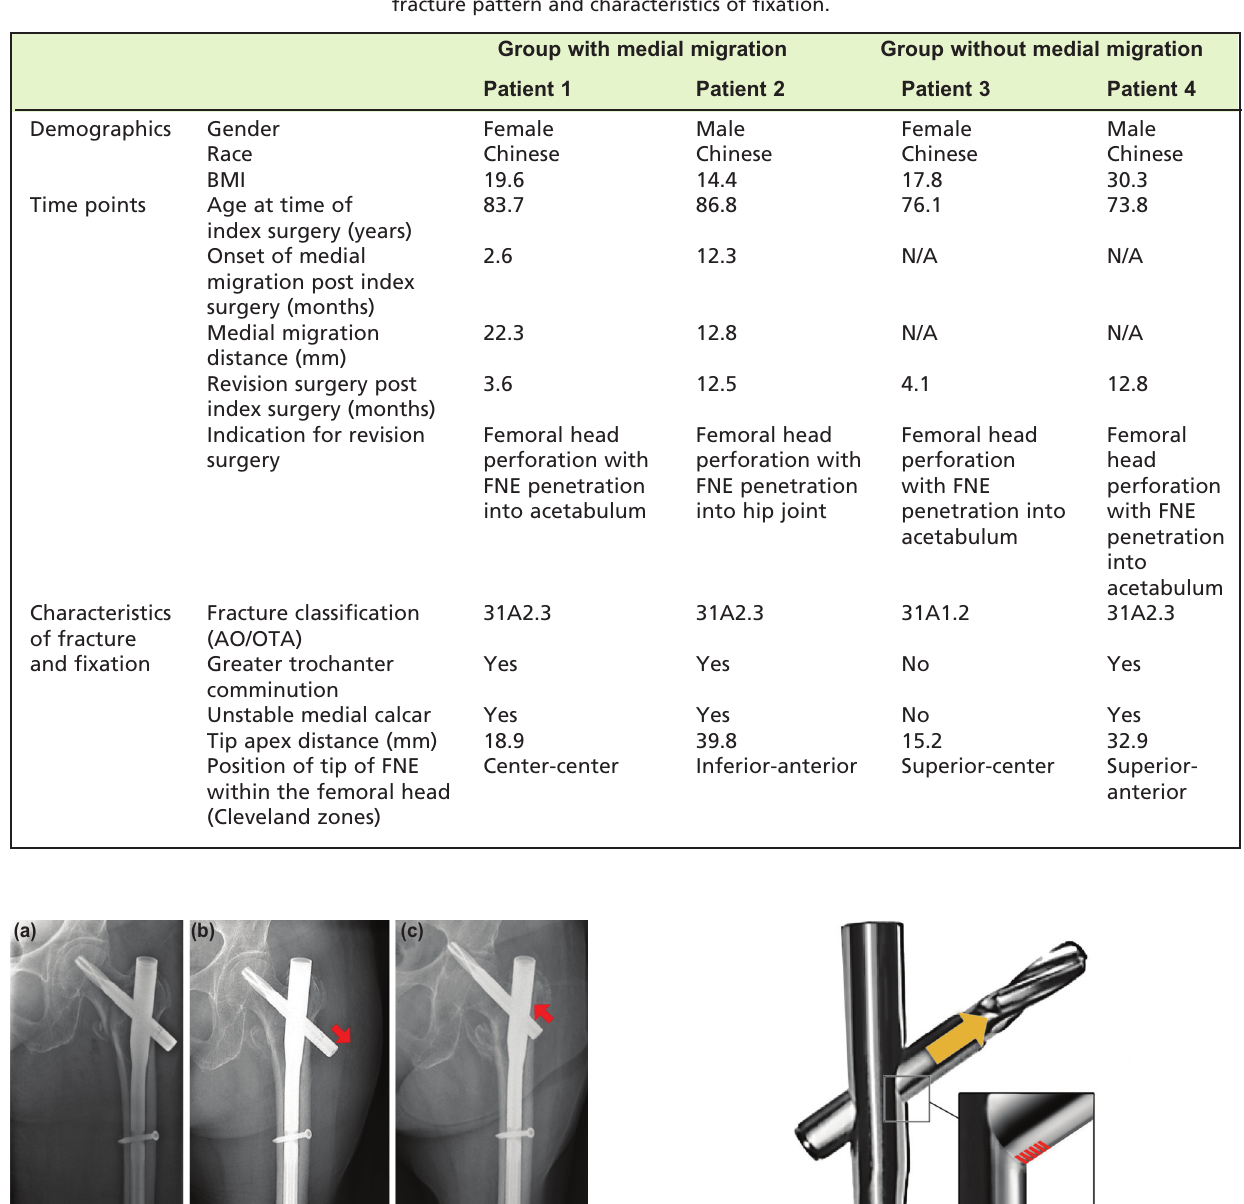
Summary of patients’ demographics, onset of medial migration, medial migration distance, time points of surgery, Table II: fracture pattern and characteristics of